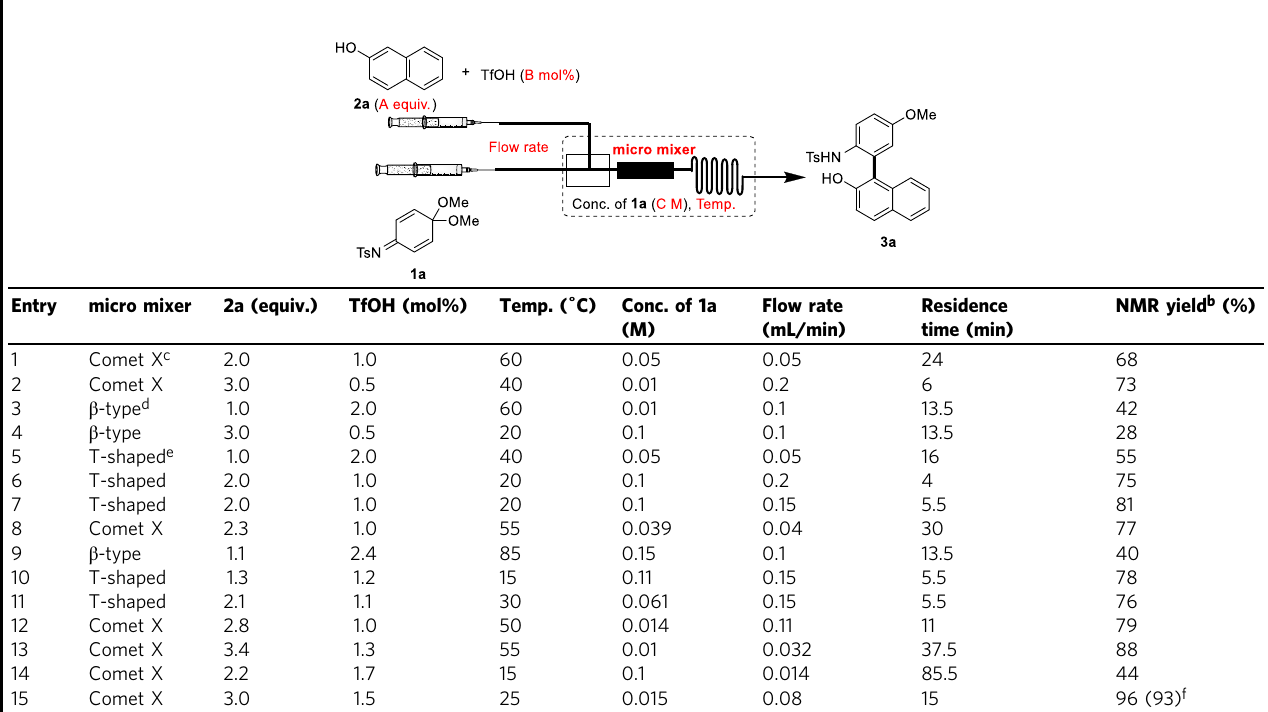
Volume of T-shaped microreactor = 1.6mL. f Isolated